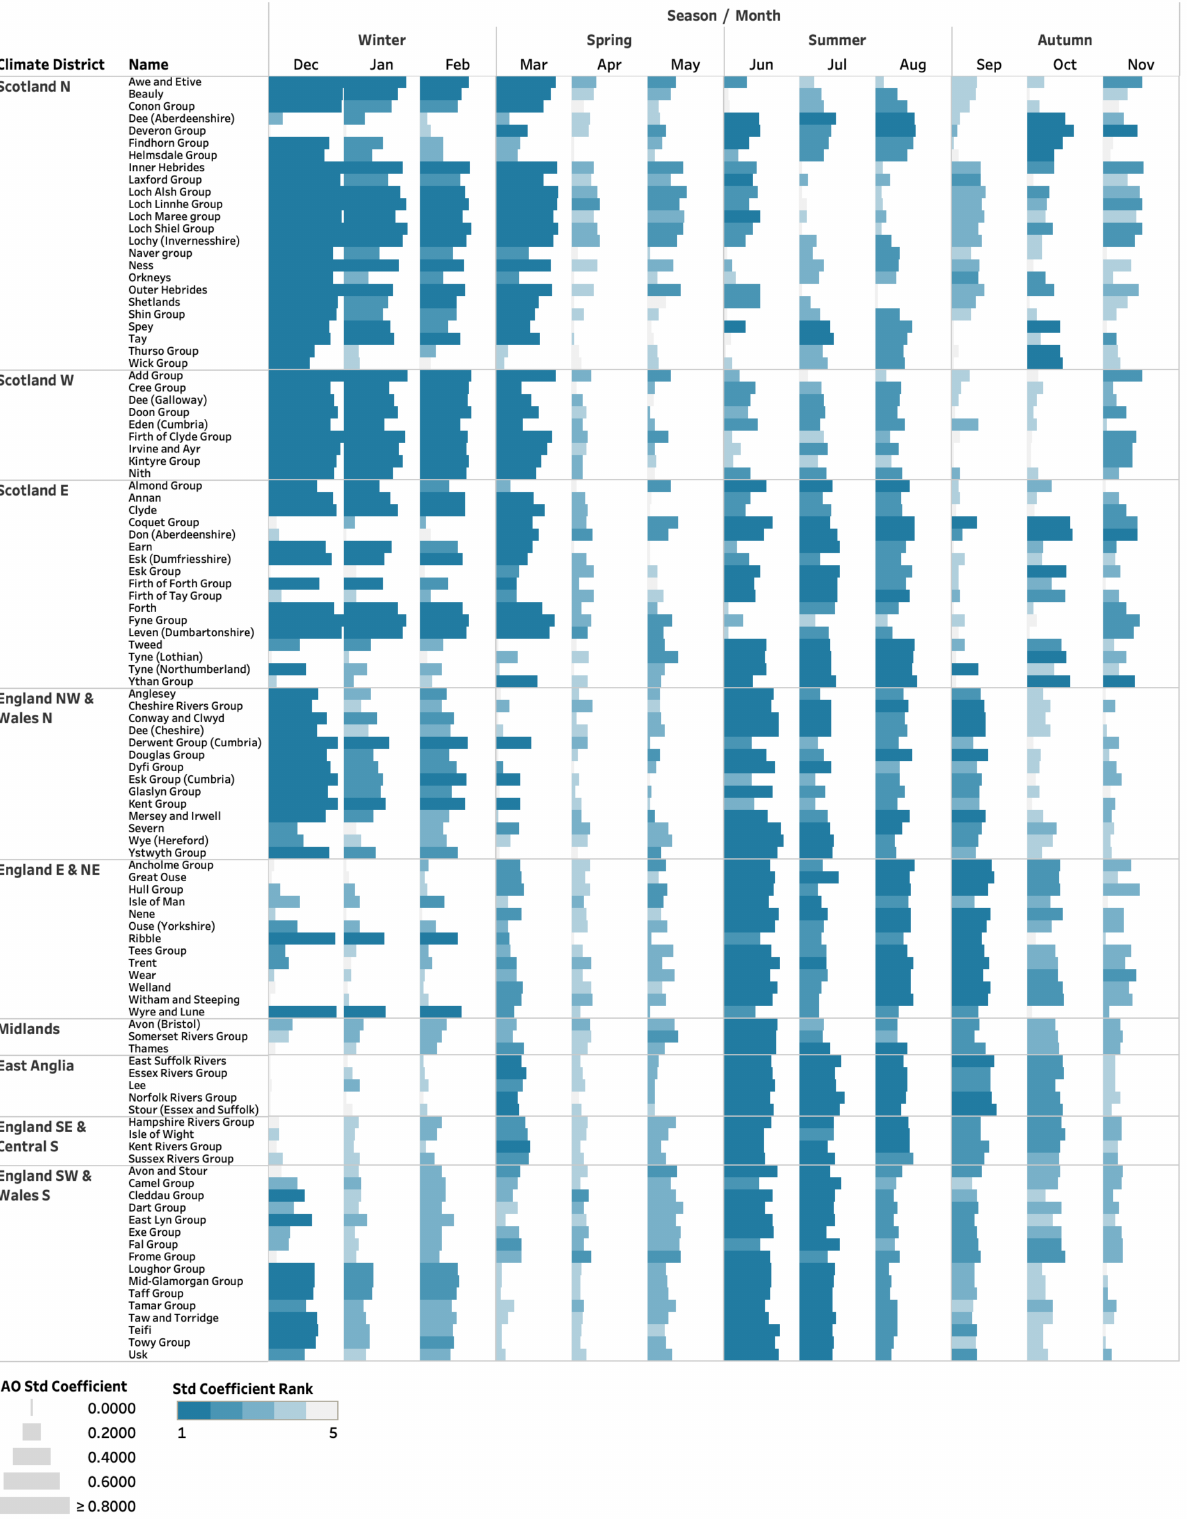
Figure A4. Rank of the NAO Standardised Coefficient. Colour represents the rank, with darker colours signifying greater influence (higher rank). Size is dependent on the magnitude of the